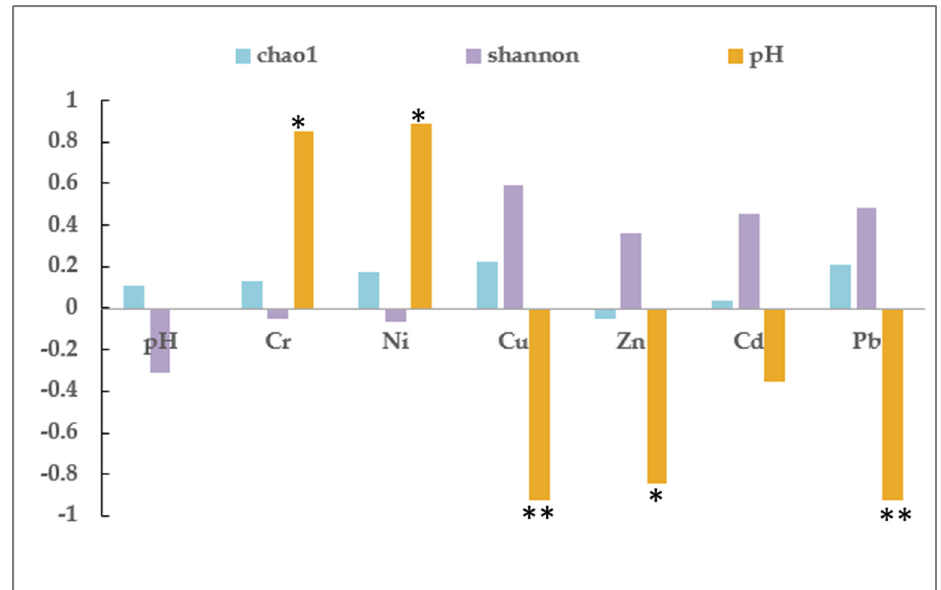
Figure 5. Correlation coefficients of the heavy metal concentrations and the Chao1, Shannon, and pH values (Pearson test; *: p < 0.05; **: p < 0.01).